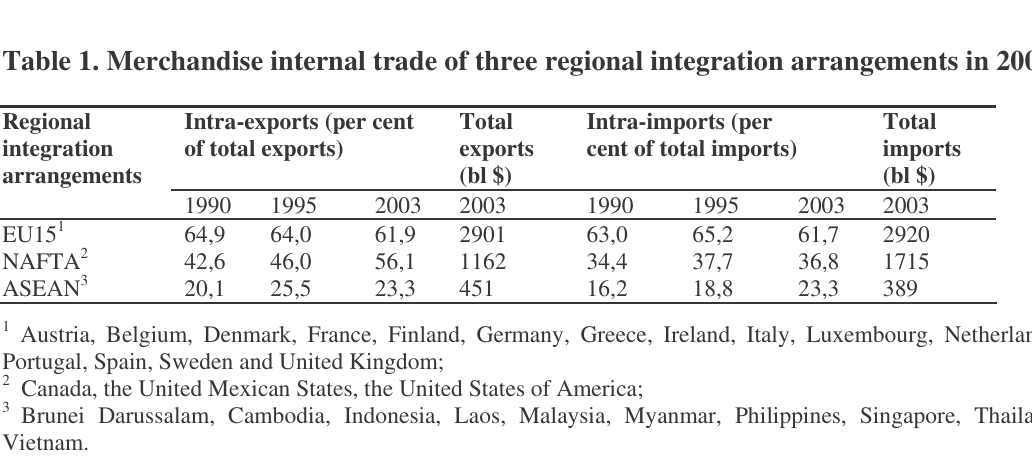
Intra-imports (per Total cent of total imports) exports (bl $)